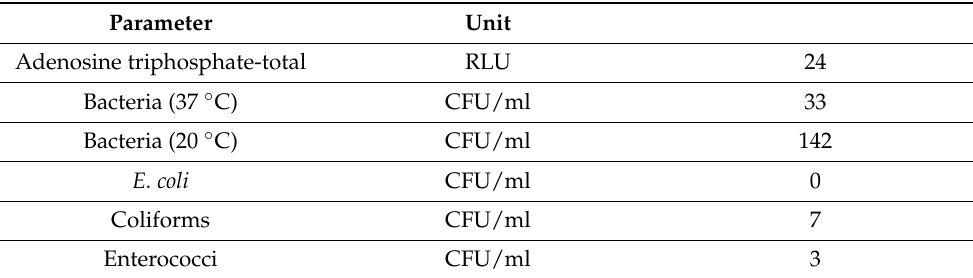
Table 3. Results of microbiological analyses (date of sampling 23 July 2018).